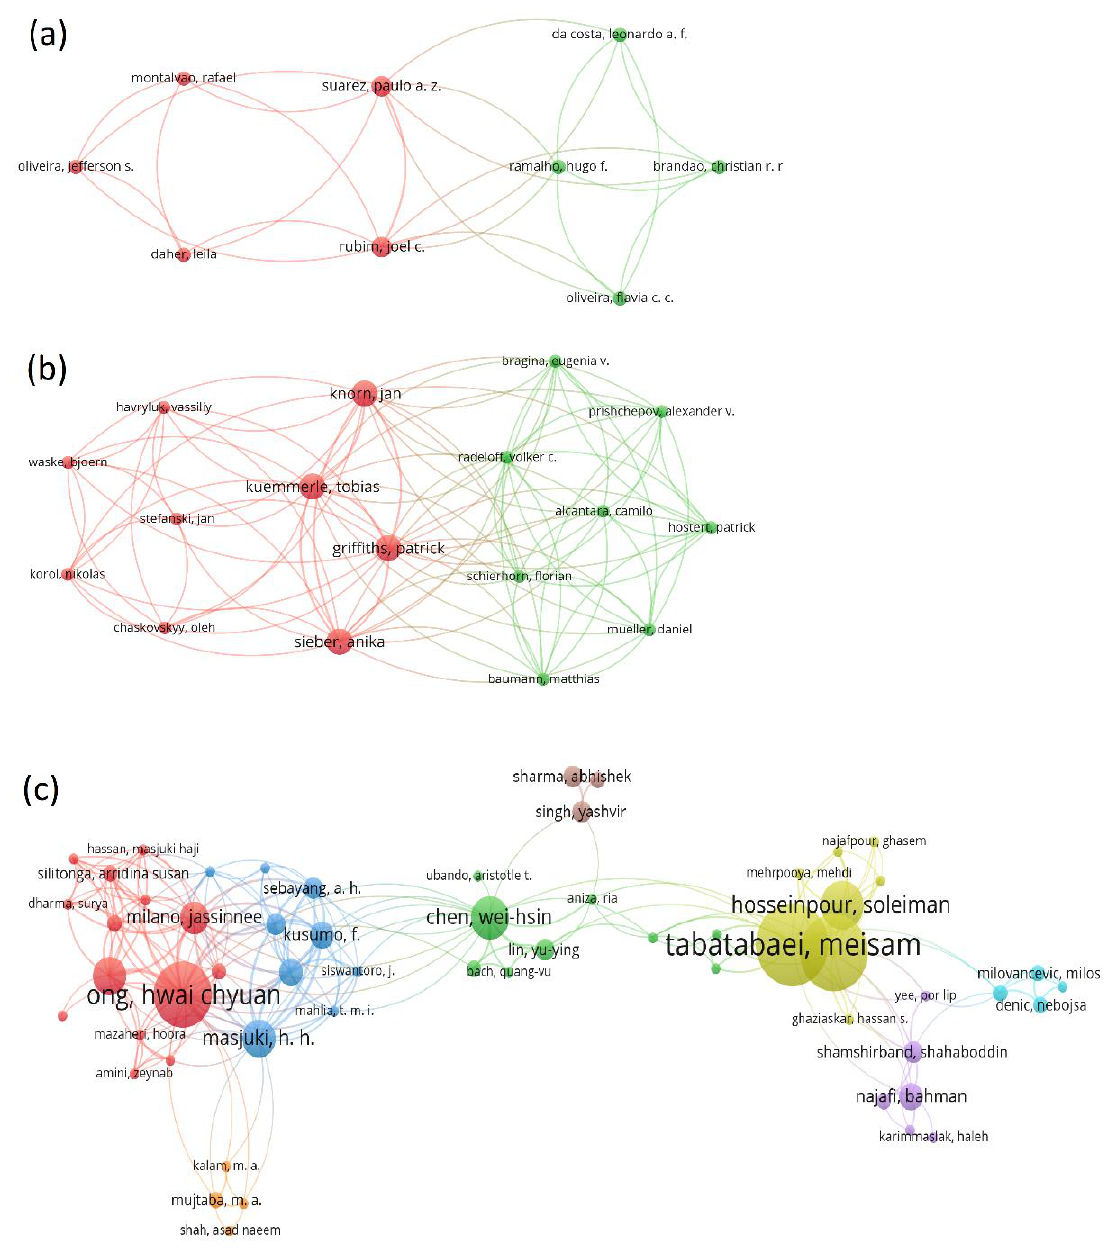
Figure 5. Co-authorship map of authors highlighting their contribution to AI in bioenergy research between the years before 2008 ( a ), 2009–2015 ( b ), and 2016–2021 ( c ). The maps in ( a , b ) had a minimum of 3 publications, and ( c ) had a minimum of 8 publications.